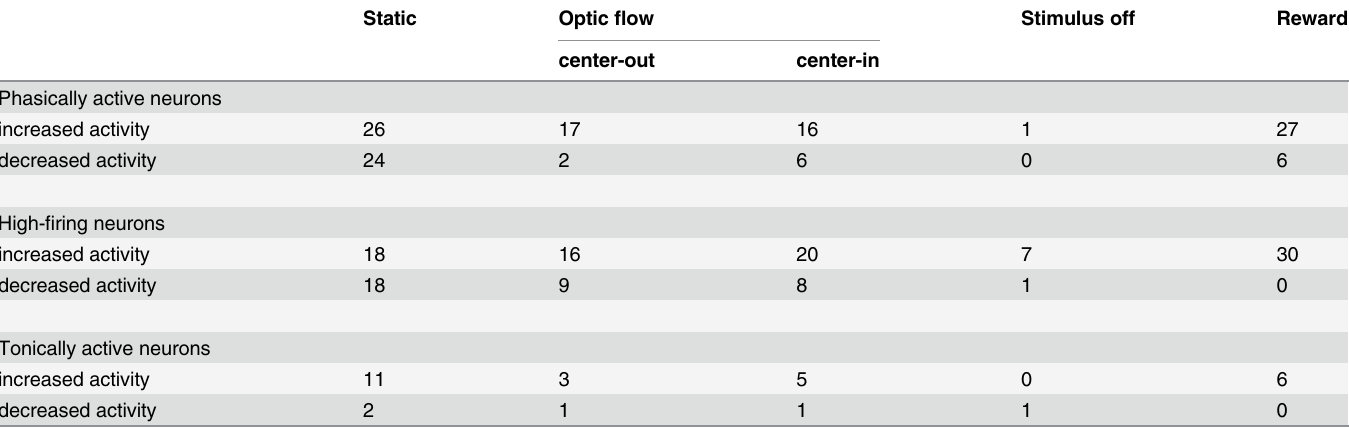
Table 1. The number of responsive CN neurons by the different phases of the applied